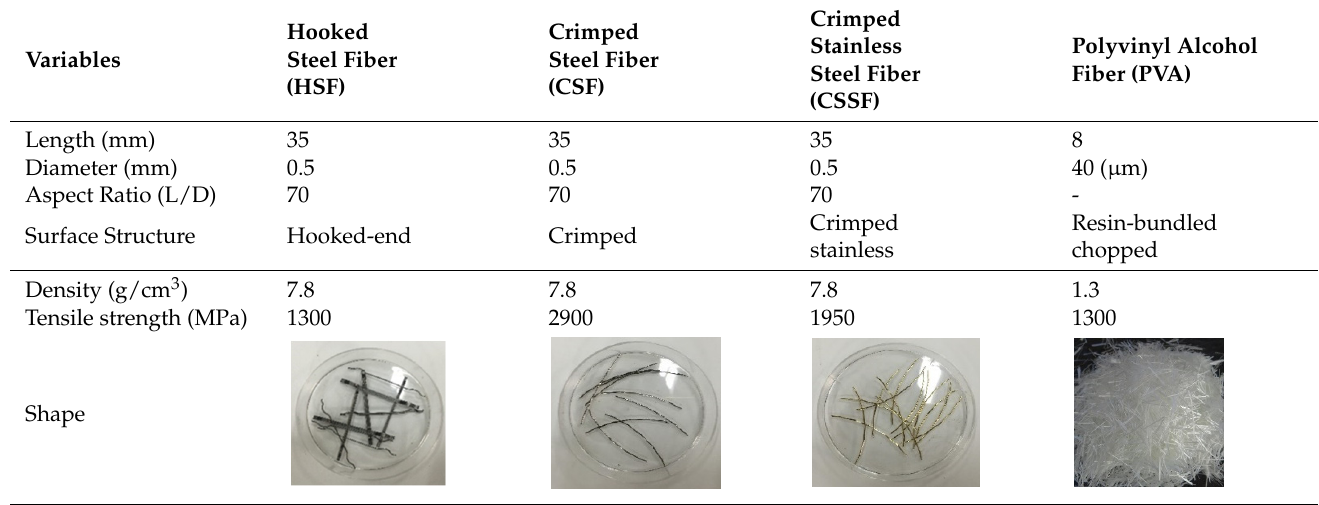
Table 2. The properties of different fibers.